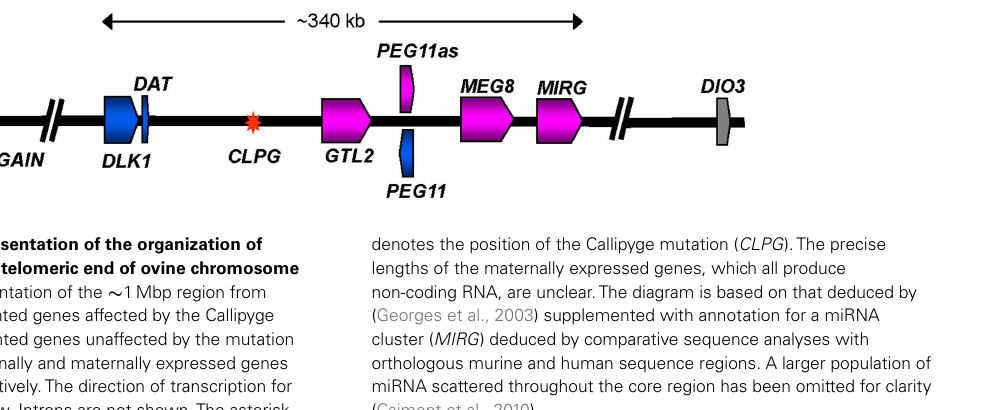
FIGURE 3 | Diagrammatic representation of the organization of imprinted genes located at the telomeric end of ovine chromosome 18. The diagram shows a representation of the ∼ 1Mbp region from BEGAIN to DIO3 .The core imprinted genes affected by the Callipyge mutation are colored while imprinted genes unaffected by the mutation are shown in gray. Affected paternally and maternally expressed genes are shaded blue and pink, respectively.The direction of transcription for each gene is indicated by an arrow. Introns are not shown.The asterisk